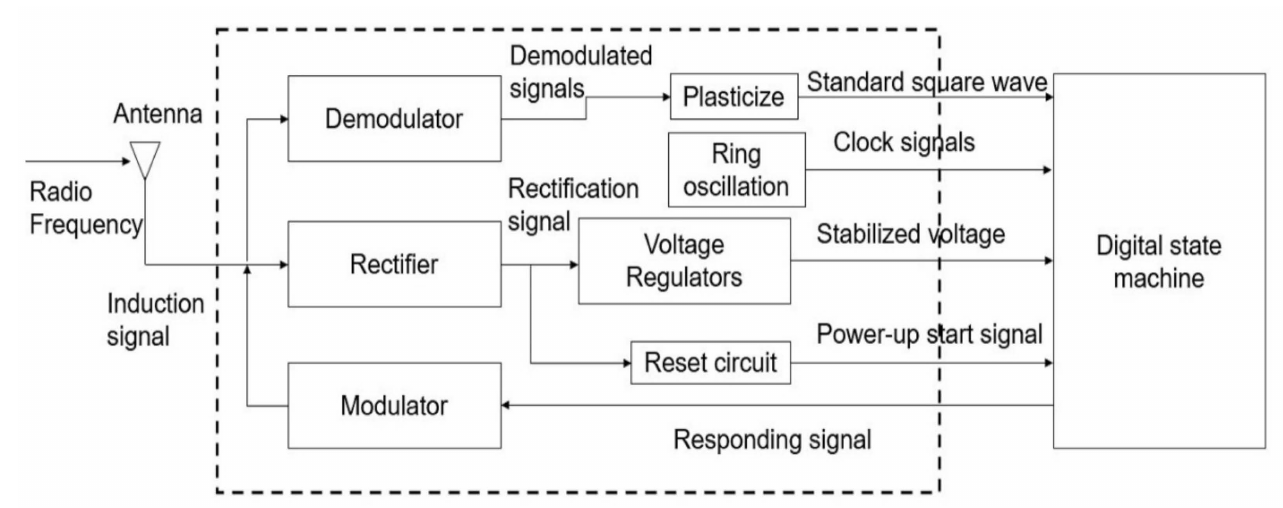
Figure 2. Block diagram of passive UHF RFID